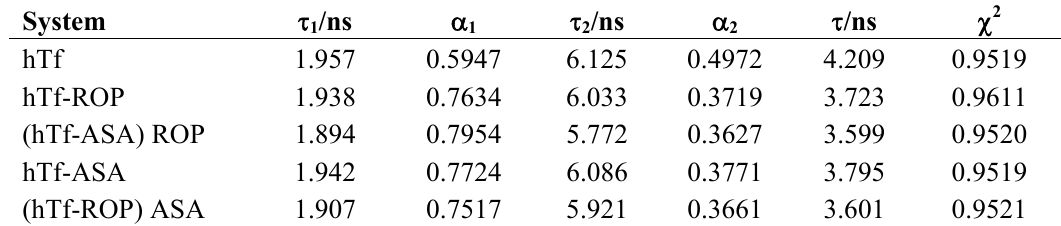
Table 4. Lifetime of hTf in the presence of ROP and ASA as binary and ternary systems, (  : the relative amplitude and  2 : the error in the calculated fluorescence) at pH 7.4, = 295 T = 298 K and λ ex